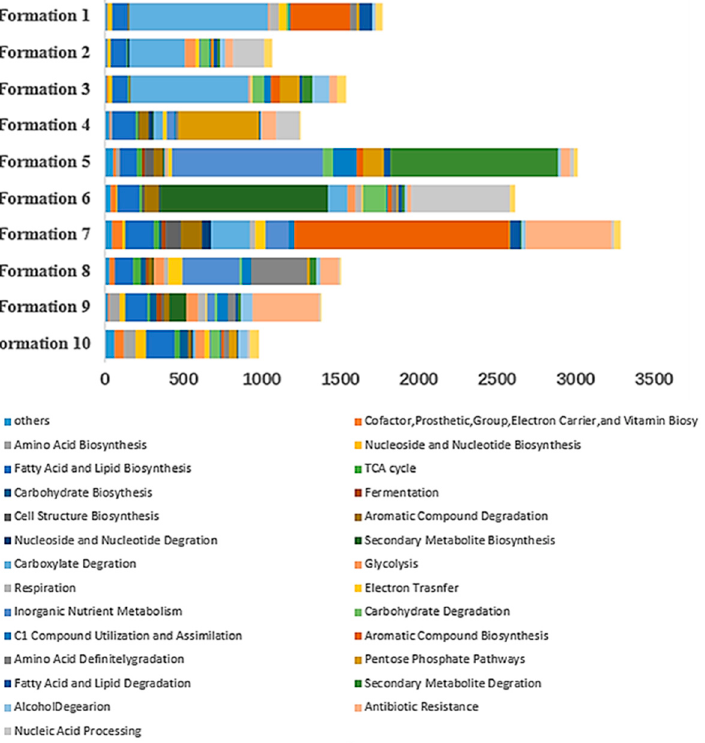
Figure 10. Stratigraphic baseline map. The stratigraphic baseline map shows the formations contained at different depths and their abundance, and different formations are indicated by different colors.